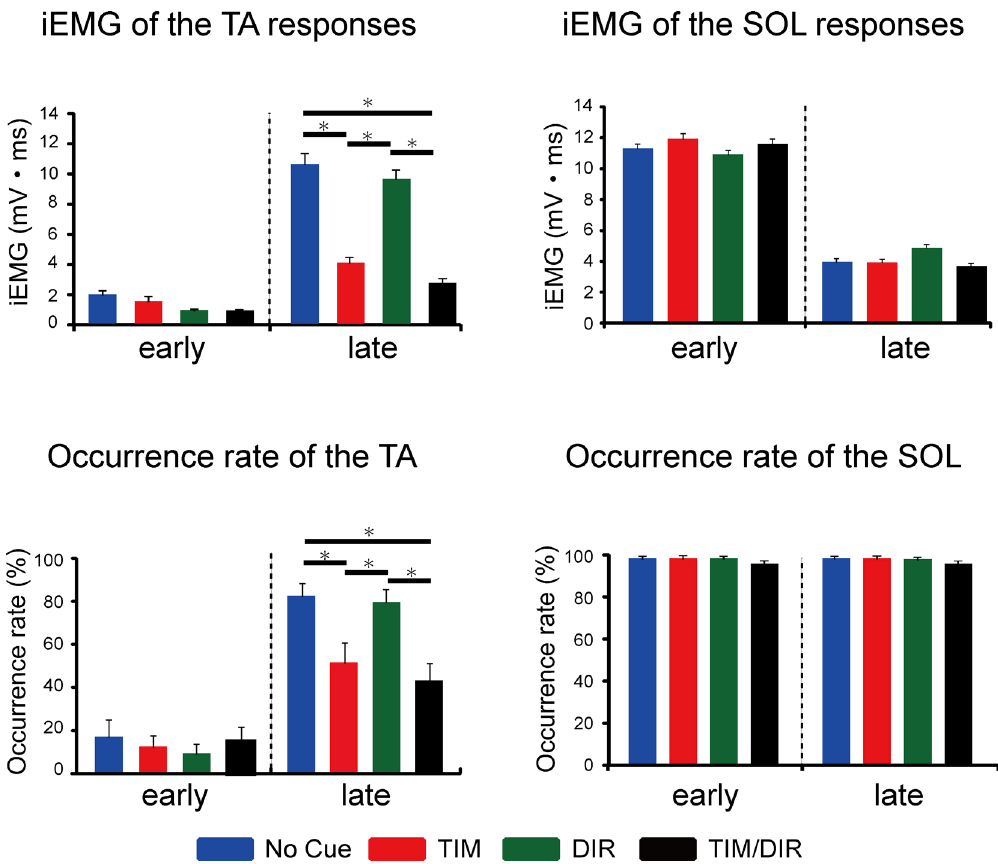
Fig 3. Comparisons of the iEMG and occurrence rate of each reflex component in the TA and SOL among the different cue conditions while standing. The iEMG error bars indicate the SE of the mean value. The occurrence rate error bars indicate the SE of the mean value. * Statistically significant difference (p <